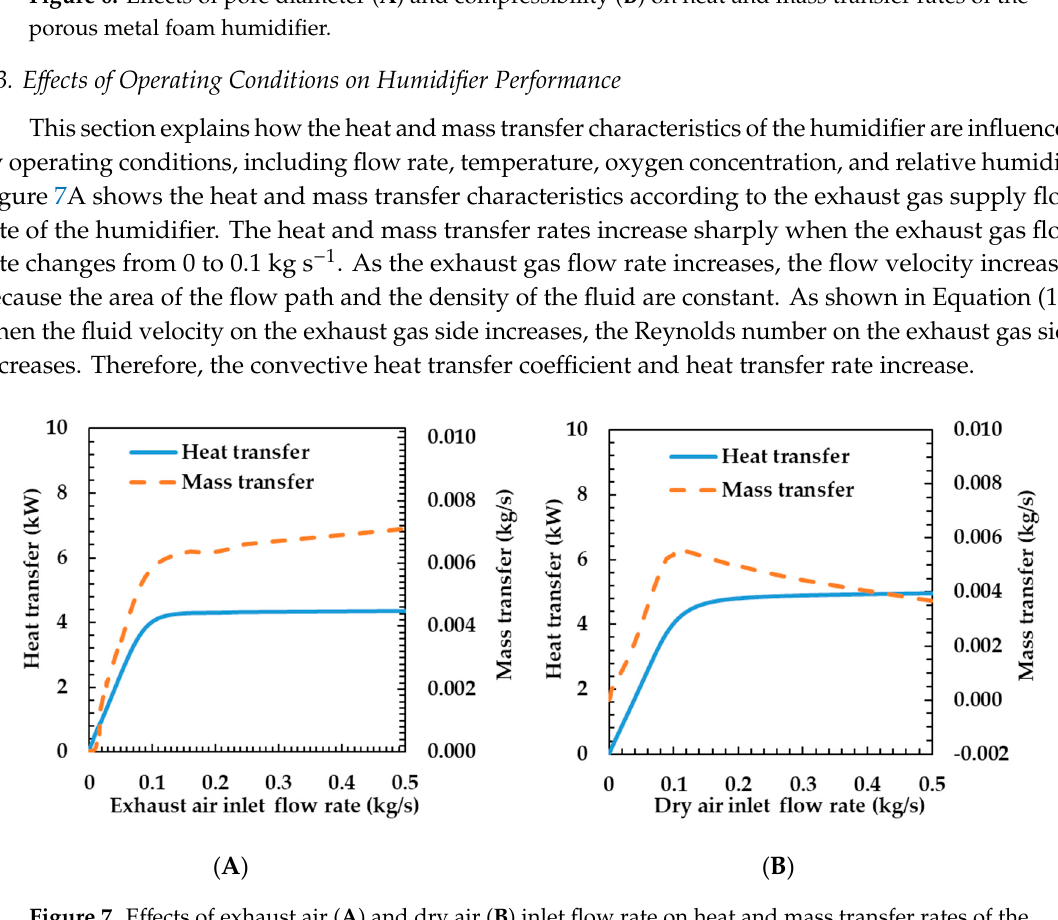
Figure 6. Effects of pore diameter ( A ) and compressibility ( B ) on heat and mass transfer rates of the porous metal foam humidifier.